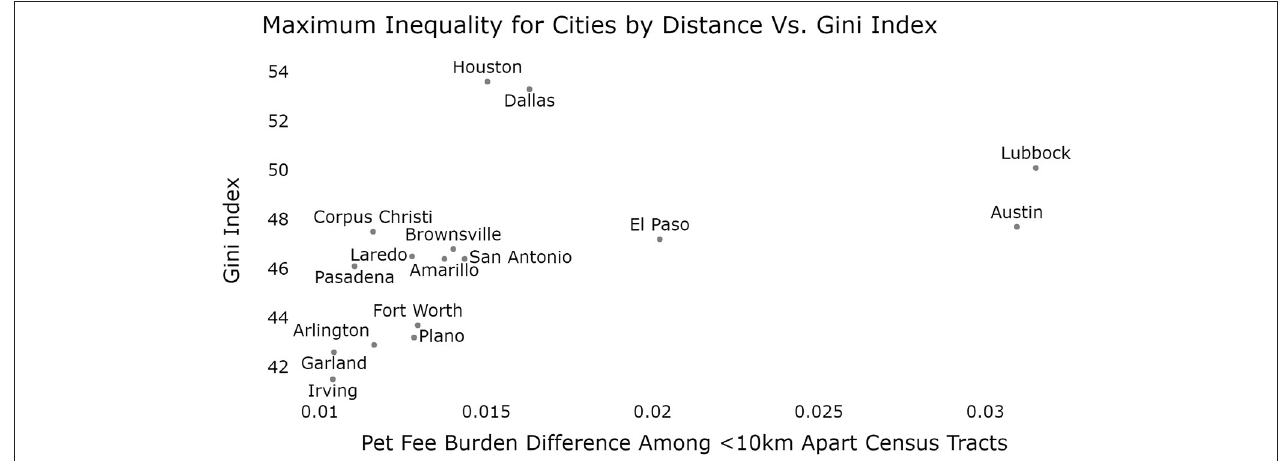
FIGURE 4 | Relationship between Gini index and pet fee burden difference for census tracts < 10km apart, by city. Austin and Lubbock can be seen as clear outliers in their spatial pet fee burden difference with El Paso also possibly representing a deviation from the typical relationship.